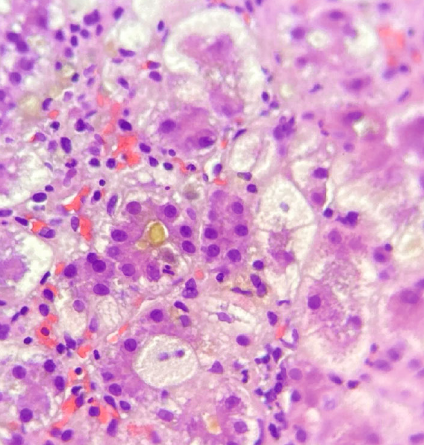
Figure 3: Canalicular cholestasis. Note the green-orange pigment located inside the canaliculus. On the right, ballooned hepatocytes (400x, H&E staining). Source: own .